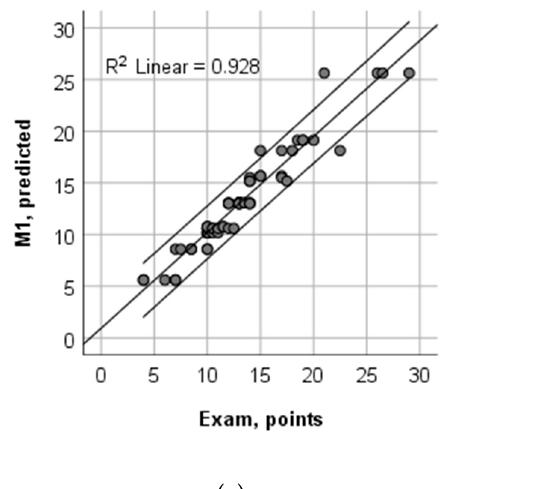
Figure 5. Diagram of the regression tree of CART model M 4 with split variables denoted and respective threshold values for each tree node.